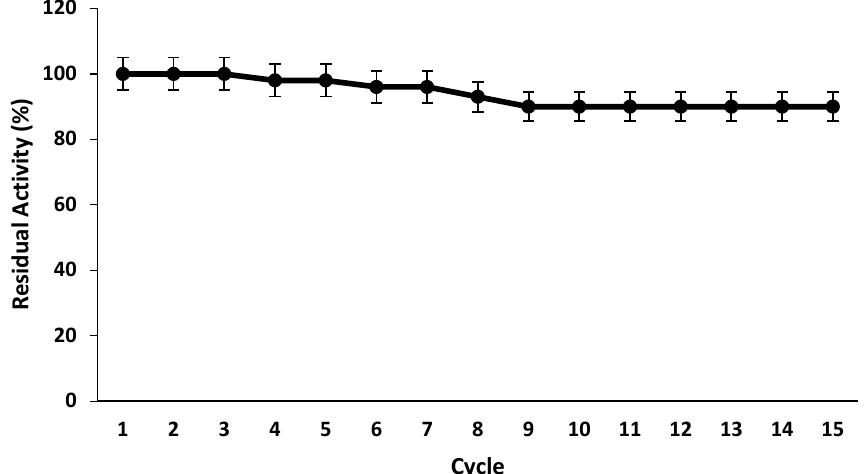
Figure 10. Reusability of pectinase immobilized magnetic iron oxide nanocarrier in reaction cycles.